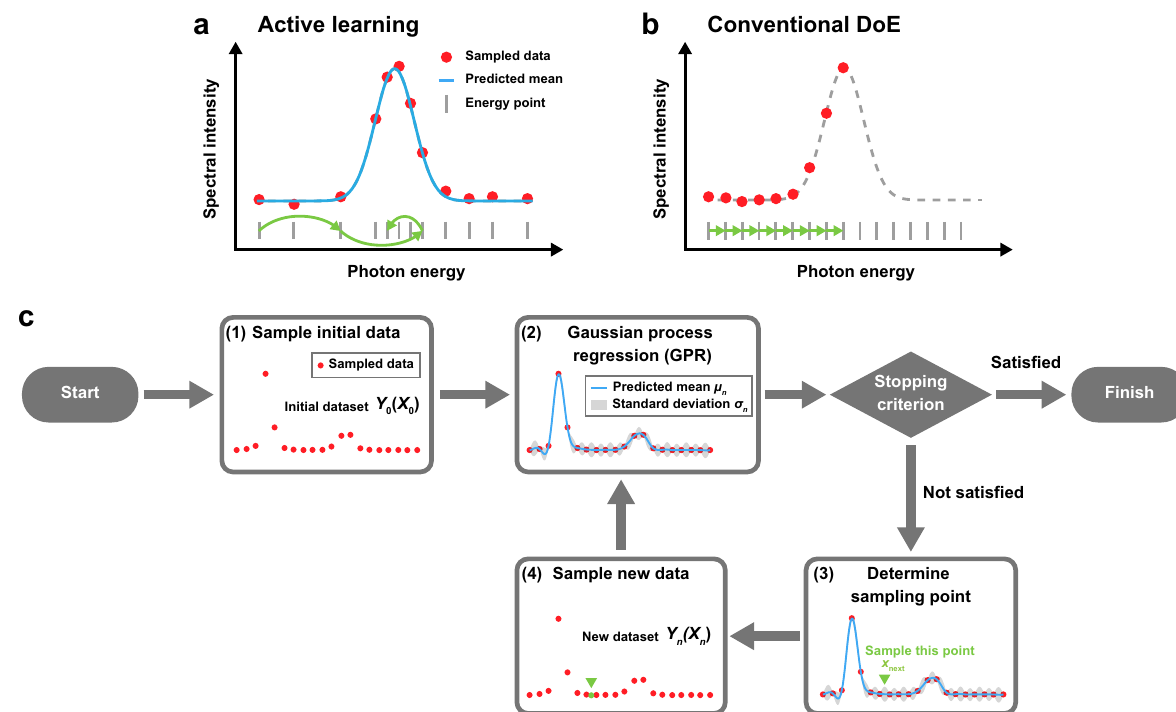
Fig. 1 Concept of the spectral measurement with active learning. a Schematic of the spectral measurement with active active learning. b Schematic of the spectral measurement with conventional design of experiments. Red markers, blue curves, and grey bars indicate the sampled data, predicted mean of Gaussian process regression, and energy points, respectively. Green arrows represent the sampling order that is determined with active learning in a or sequential sampling in b . c Flowchart of the spectral measurement with active learning. (1) A sampling of the initial data. (2) Gaussian process regression (GPR) is used to predict the spectrum and evaluate the standard deviation. The measurement is fi nished when the stopping criterion is satis fi ed. (3) If the stopping criterion is not satis fi ed, then the next sampling point is determined based on the acquisition function. (4) A sampling of new data and back to the process